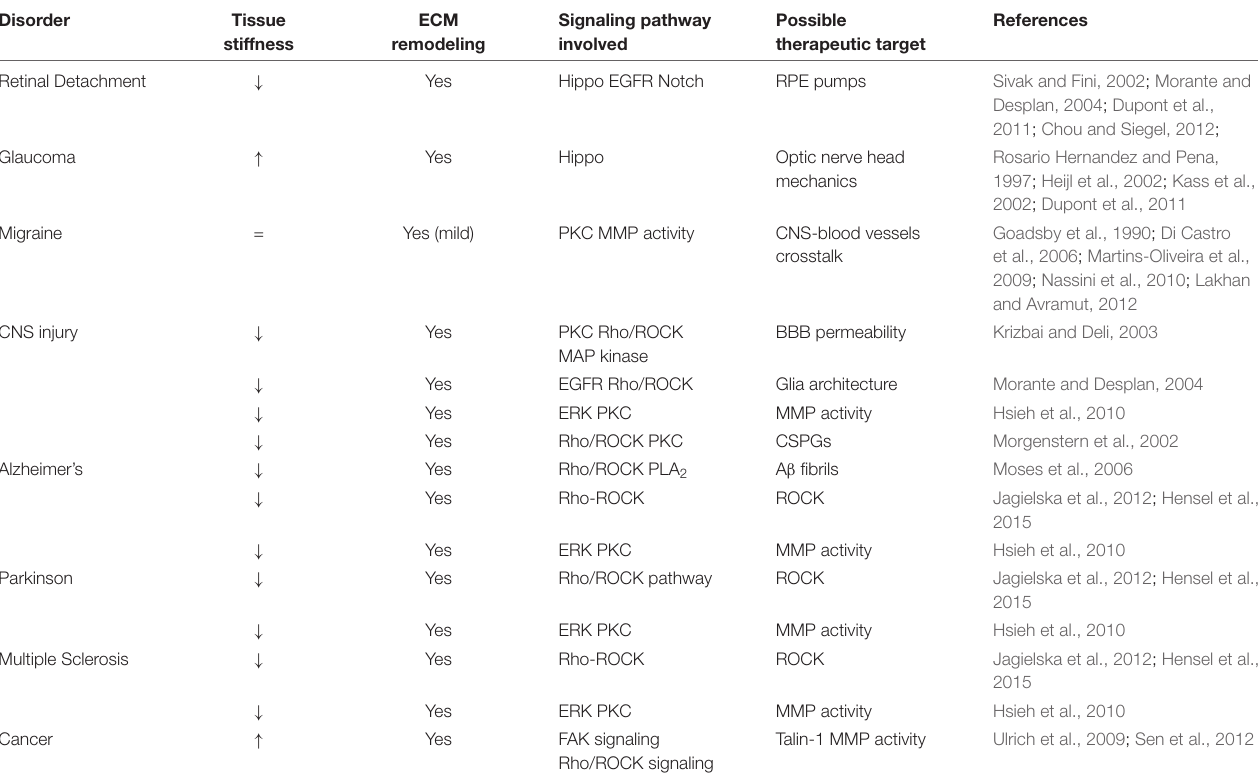
TABLE 1 | Analysis of several CNS pathologies and their impact in tissue